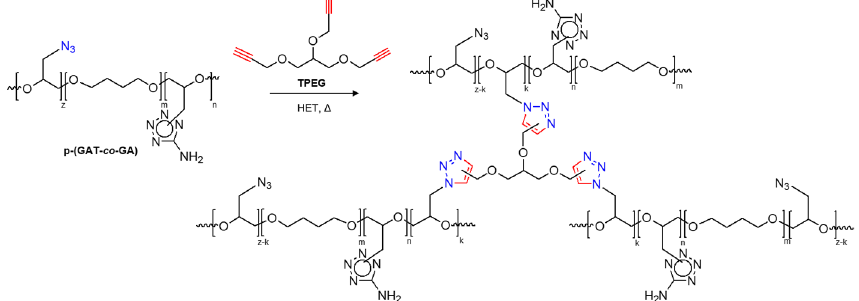
Figure 7. A time course of the viscosity of solutions based on p ‐ (GAT ‐ co ‐ GA) copolymers when cured at 80 °C (60 °C) (a constant shear rate of 0.05 s − 1 ).